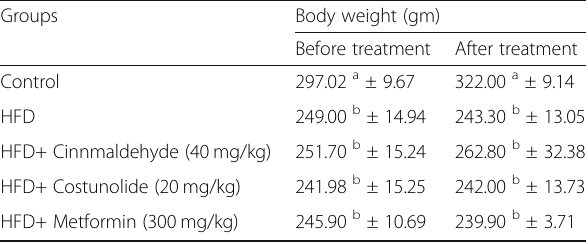
Table 2 Effect of oral administration of cinnamaldehyde and costunolide on body weight in HFD fed rats for 30 days Groups Before treatment After